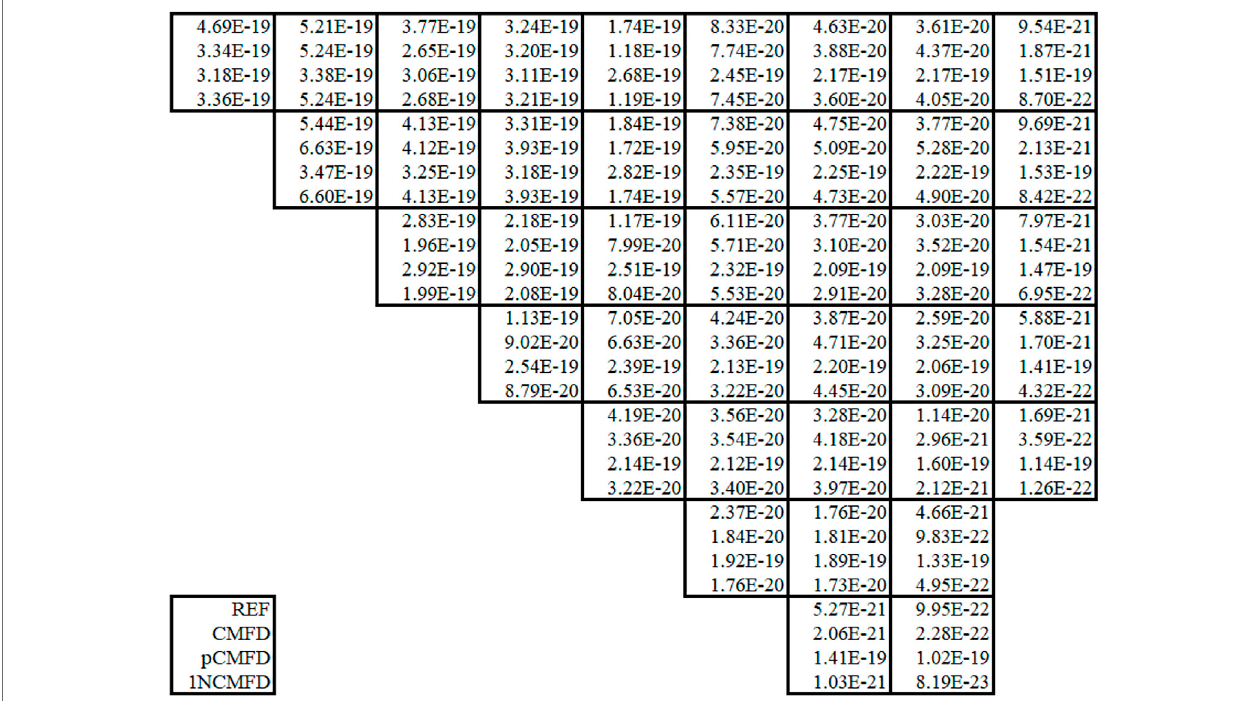
FIGURE 9 | Fast group numerical adjoint fl ux for the KWU 2D problem.